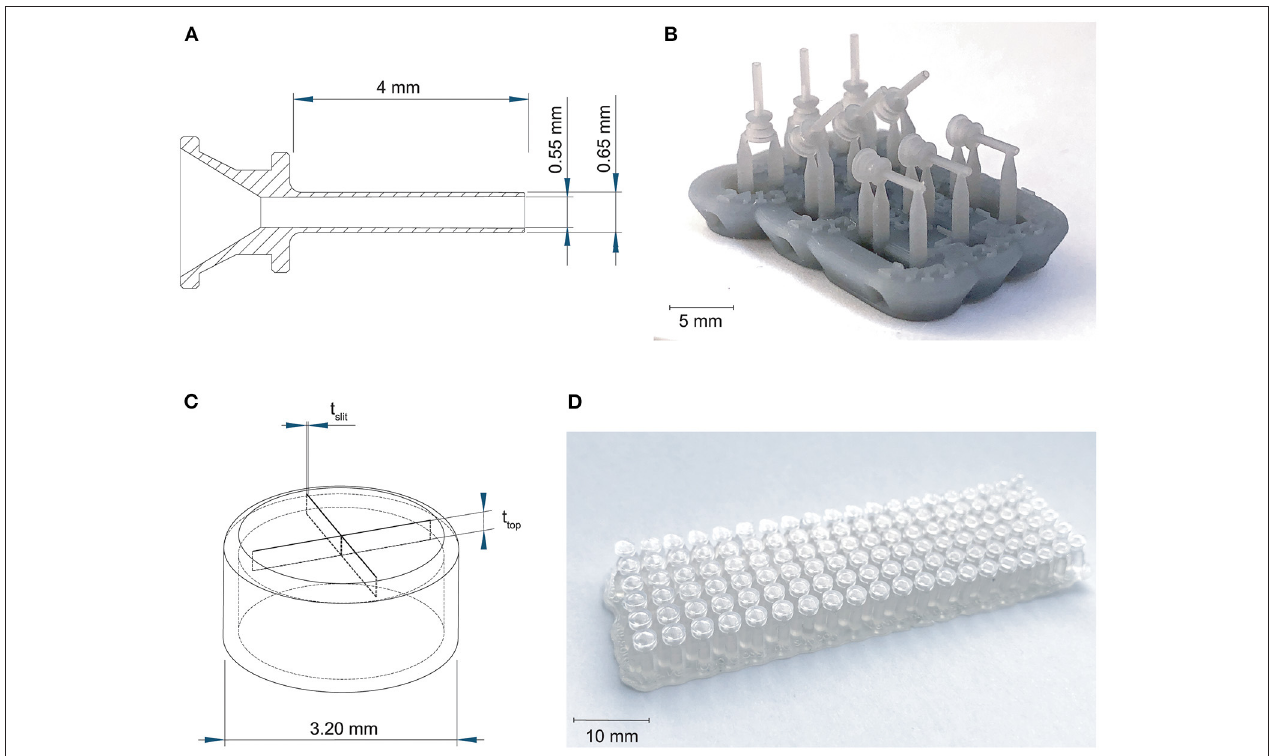
FIGURE 2 | Overview of the 3D printed cannulas and valves. (A) Design and dimensions of the printed cannula; (B) example of the 3D printed cannulas in three different orientations, still on their support structure; (C) design and the dimensions that were tested for the valve, in which t slit is the thickness of the slits, and t top is the thickness of the top; (D) example of the 3D printed valves with different dimensions, still on their support